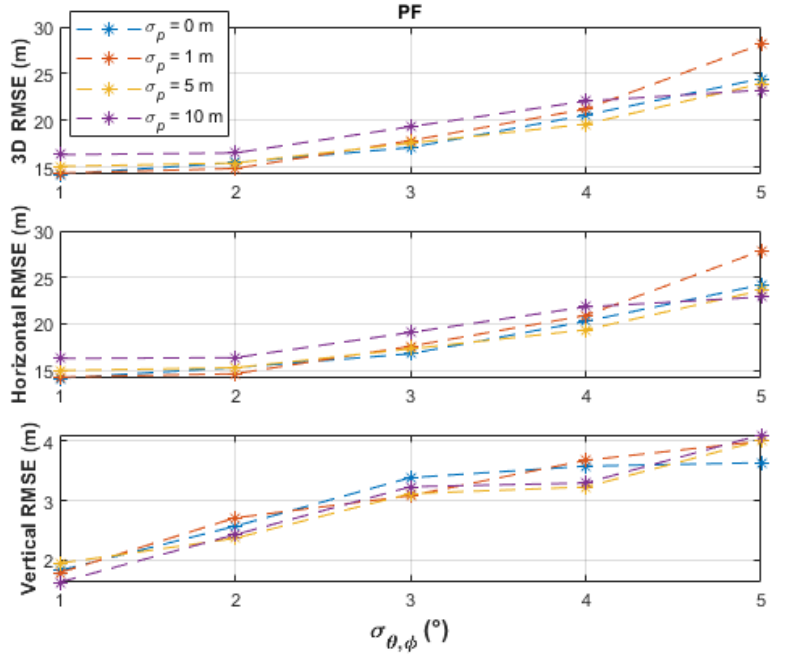
Figure 8. Performance comparison of the PF batch-processing solution under different levels of UAS position uncertainties and using 101 measurement points.